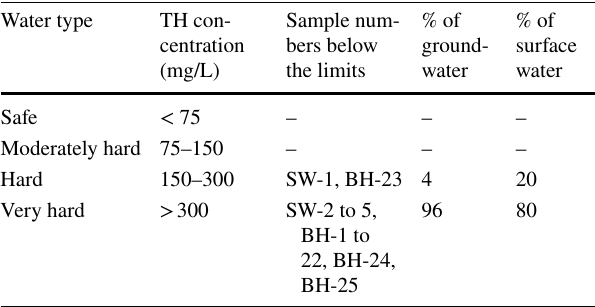
Table 5 Distribution of water samples based on the classification of TH Water